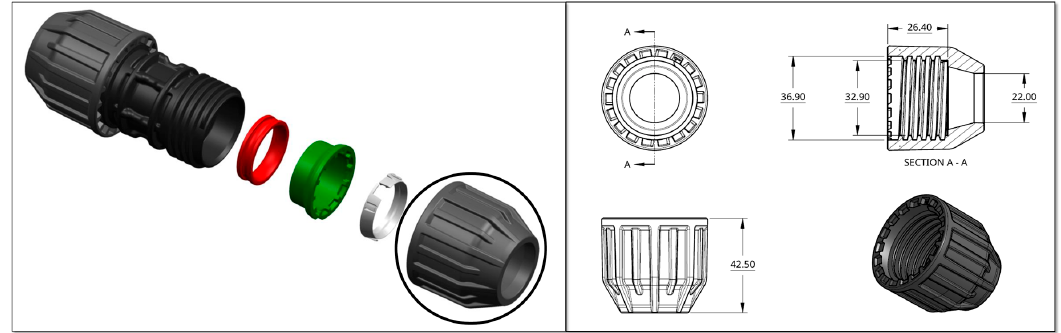
Figure 10. Fitting assembly for the connection of plastic pipes including all the involved components (left) and detailed technical drawing of the produced injection-moulded cap with tolerances according to DIN16742 TG5 (right).